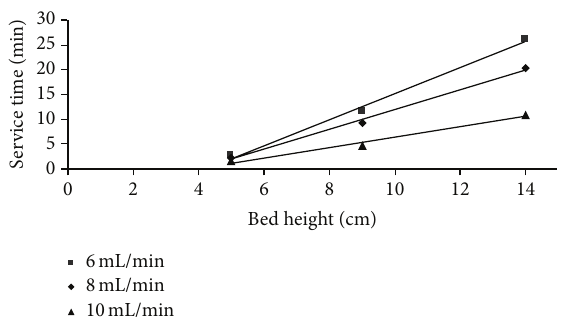
Figure 5: BDST plots for various flow rates for poly(EGDMA- VIM). Conditions: 𝐶 0 11.9mg L −1 ; ( ◼ ) 6mL/min experimental; ( Q ) 8mL/min experimental; ( 󳵳 ) 10mL/min experimental; (—)